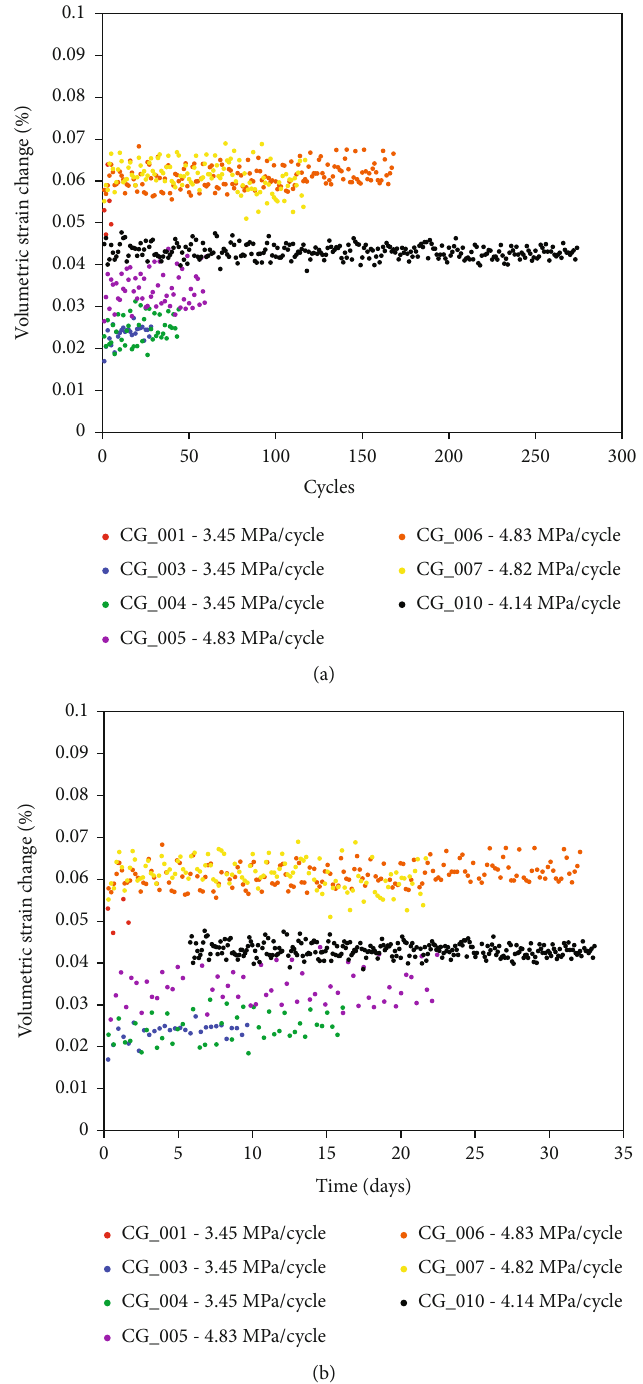
Figure 6: Change in volumetric strain during the unloading portion of each cycle plotted against the number of cycles (a) and time elapsed (b). Volumetric strain change is calculated from the di ff erence in the peak and valley of each cycle during the unloading